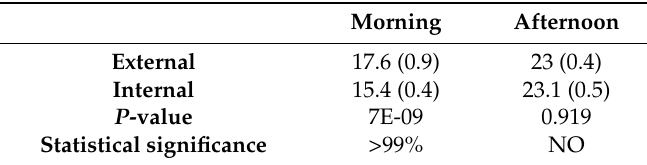
Table 5. Statistical analysis of averages of morning and afternoon temperatures, for external and internal rows (°C).